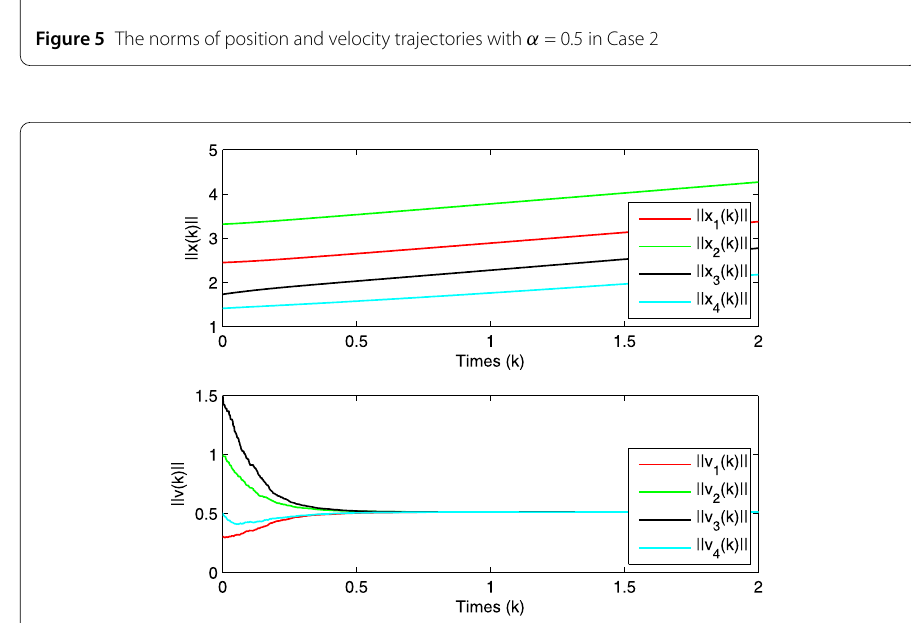
Figure 6 The norms of position and velocity trajectories with α = 1 in Case